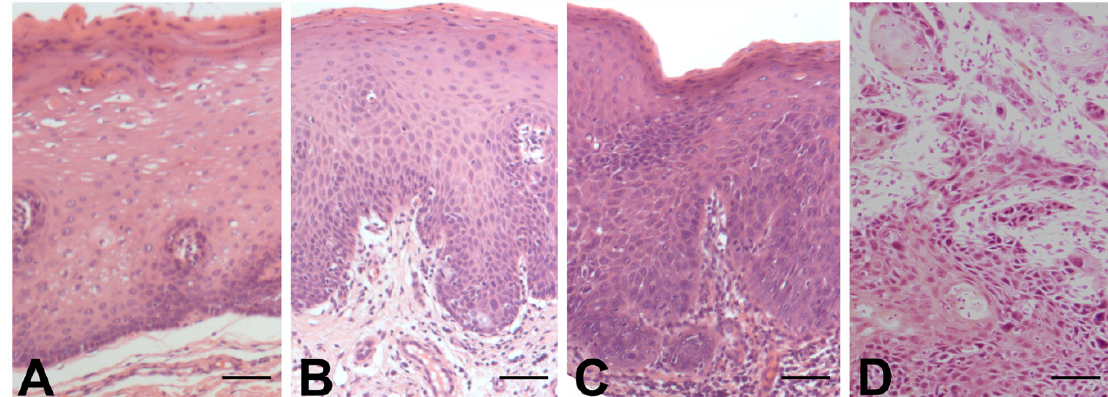
Figure 2. Representative histological images of mild (( A ), larynx), moderate (( B ), hard palate) and severe (( C ), tongue) dysplasia and of squamous cell carcinoma (SCC) (( D ), tongue). Hematoxylin–eosin. Bars: 100 µm.